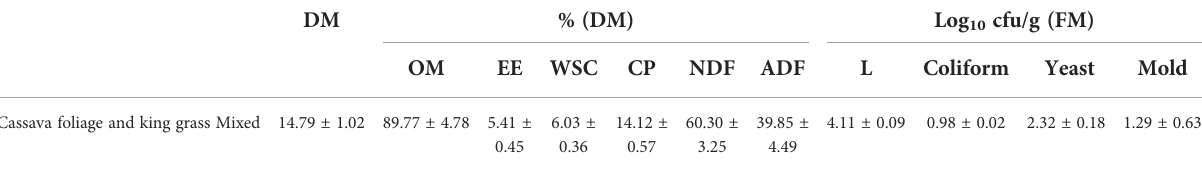
TABLE 1 Chemical composition and microbial population of fresh material before